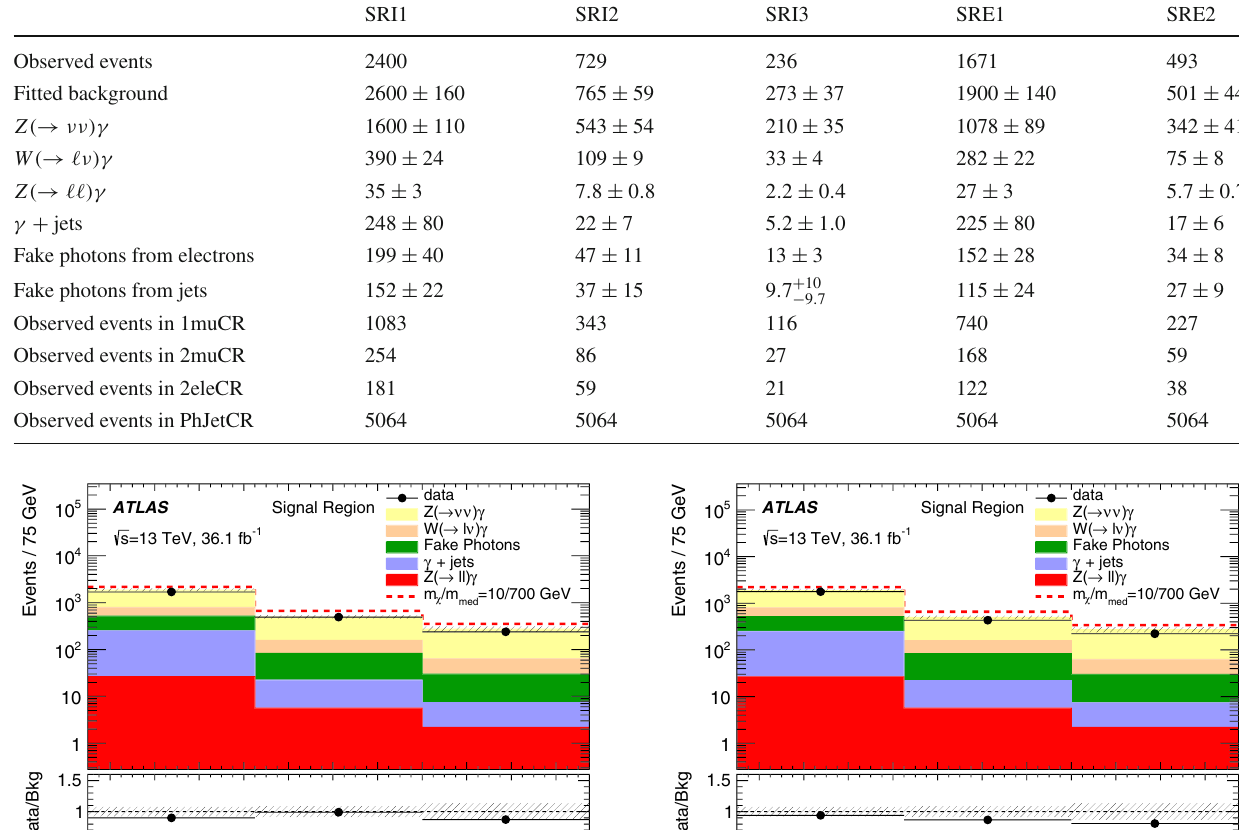
Table 5 Observed event yields in 36.1 fb − 1 of data compared to expected yields from SM backgrounds in all signal regions, as predicted fromthesimultaneousfittotheirrespectiveCRs(seetext).Thefirstthree columns report the yields obtained from the inclusive-SR fit, while the two last columns report the yields obtained from the multiple-bin fit. The uncertainty includes both the statistical and systematic uncertain- ties described in Sect. 8. The uncertainties are post-fit uncertainties and are constrained by the fit as the use of control regions to normalise